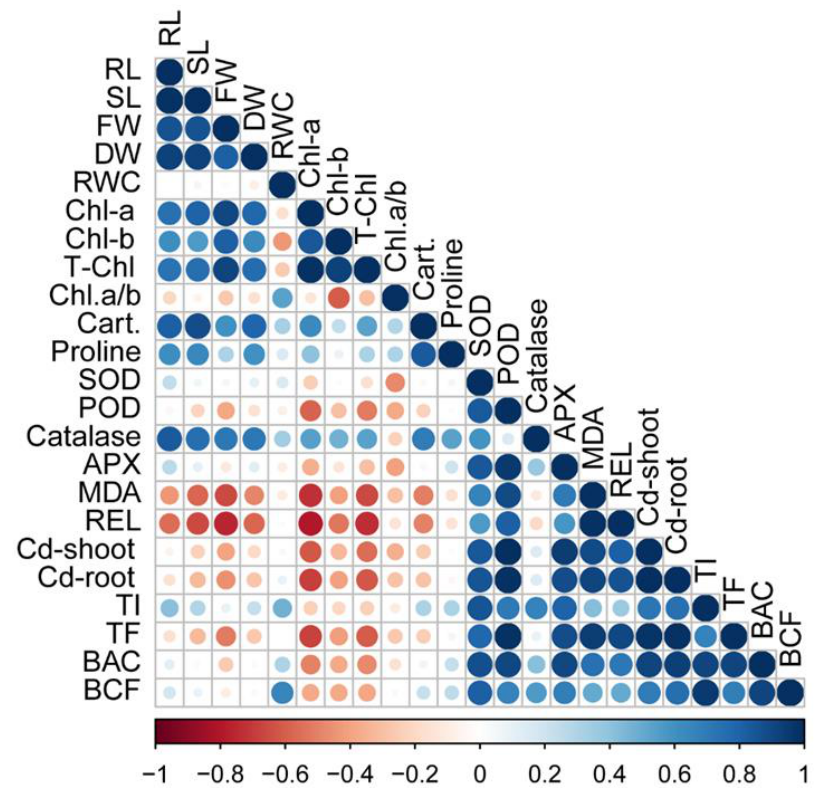
Figure 6. Pearson’s correlation analysis (r-values) between different studies’ parameters of A. rosea seedlings grown under different stress levels of Cd with and without CA application. Where PC stands for pearson’s correlation; REL for relative electrolyte leakage; TF for translocation factor; POD for peroxidase; APX for ascorbate peroxidase; BAC for bioaccumulation concentration; APX for ascorbate peroxidase; SOD for superoxide dismutase; RL for root length; SL for shoot length and RWC for relative water content.